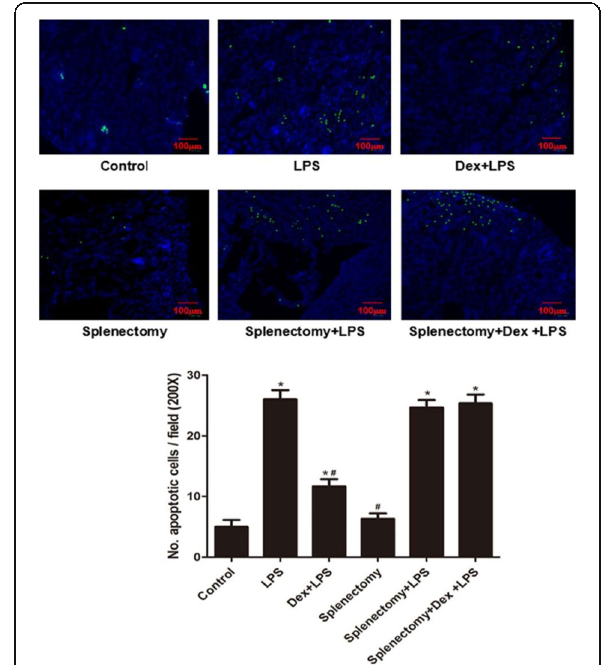
Fig. 3 (abstract 000504). HE results of renal pathology in each group